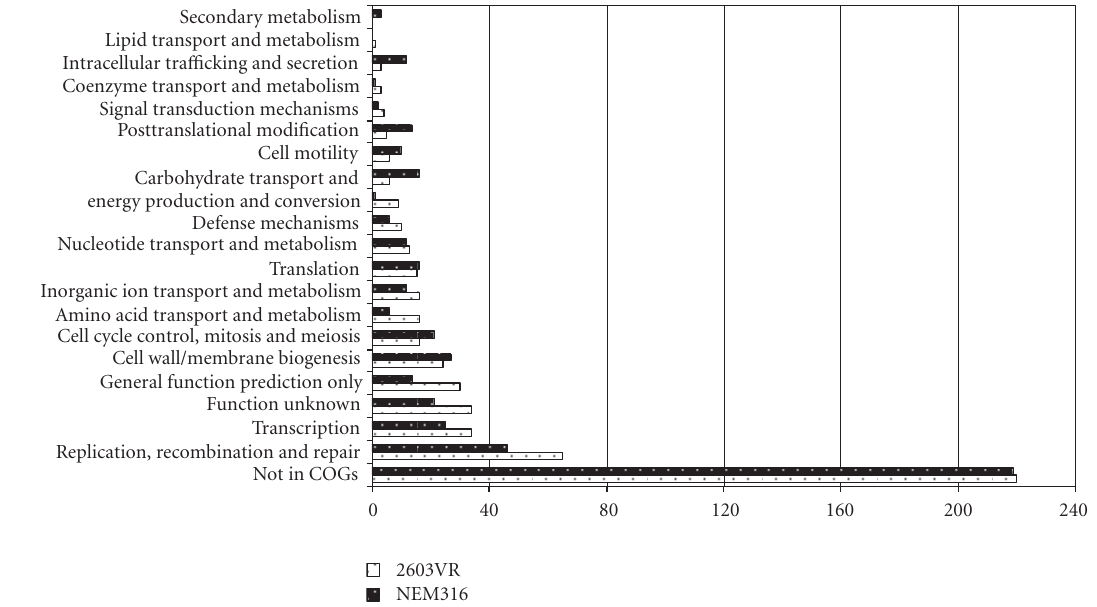
Figure 2: Number of variable open reading frames in group B Streptococcus strains NEM316 and 2603VR classified in each of the clusters of orthologous genes (COG) category plus those not classified in COG